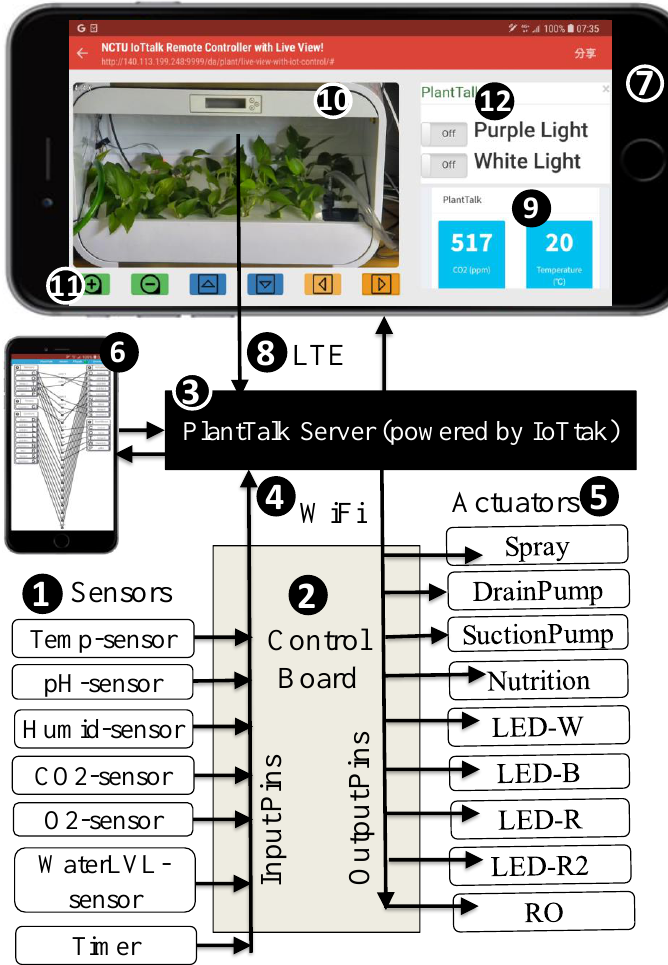
Figure 2. PlantTalk functional block diagram.